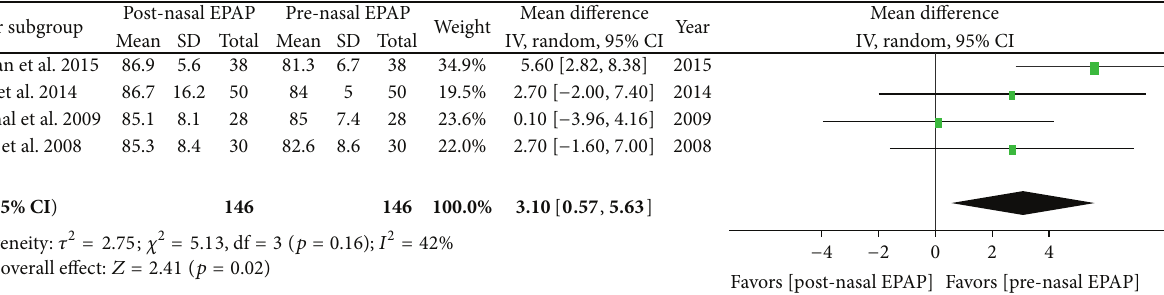
86.2 ± 11.1 % (3-point oxygenation increase); see Table 4.